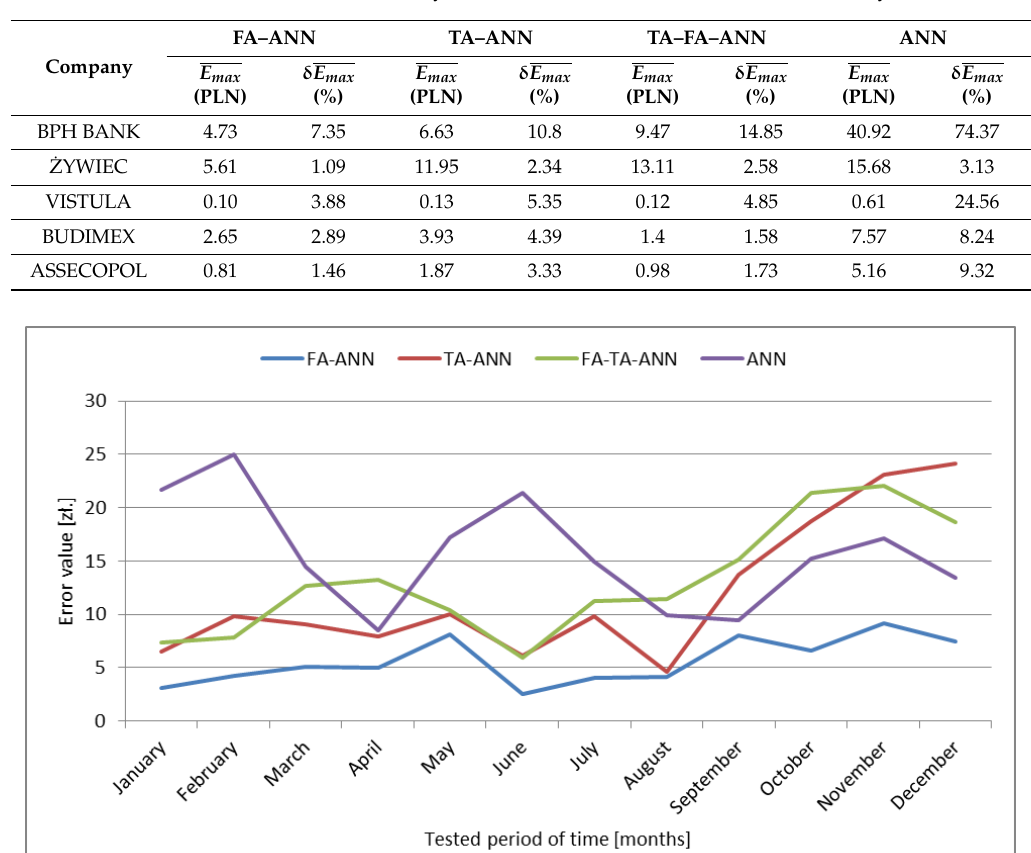
Table 2. Arithmetical means of monthly E max values (absolute and relative) for one year (2010).